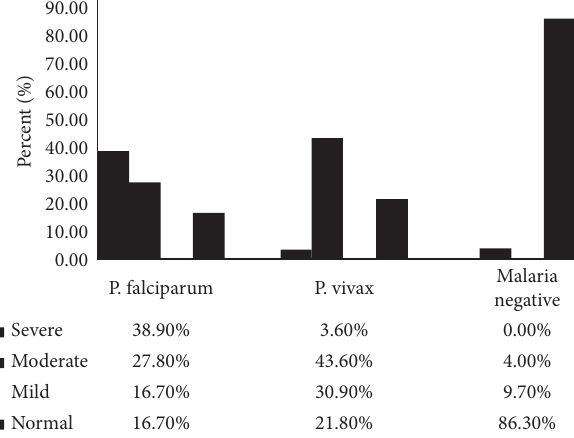
Figure 1: Severity of thrombocytopenia by malaria species in acute febrile patients.